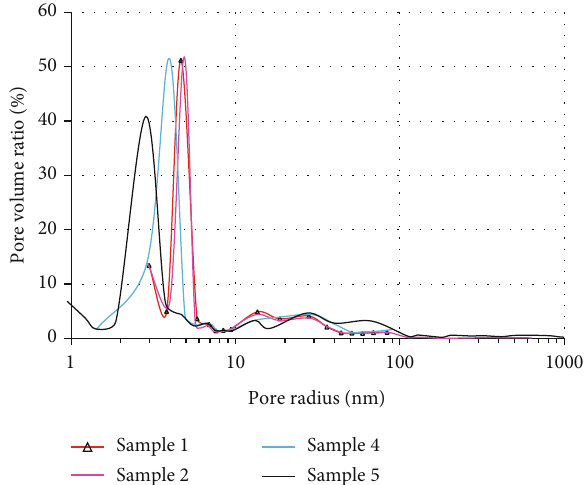
Figure 5: Pore size distribution characteristics of the adsorption- mercury injection